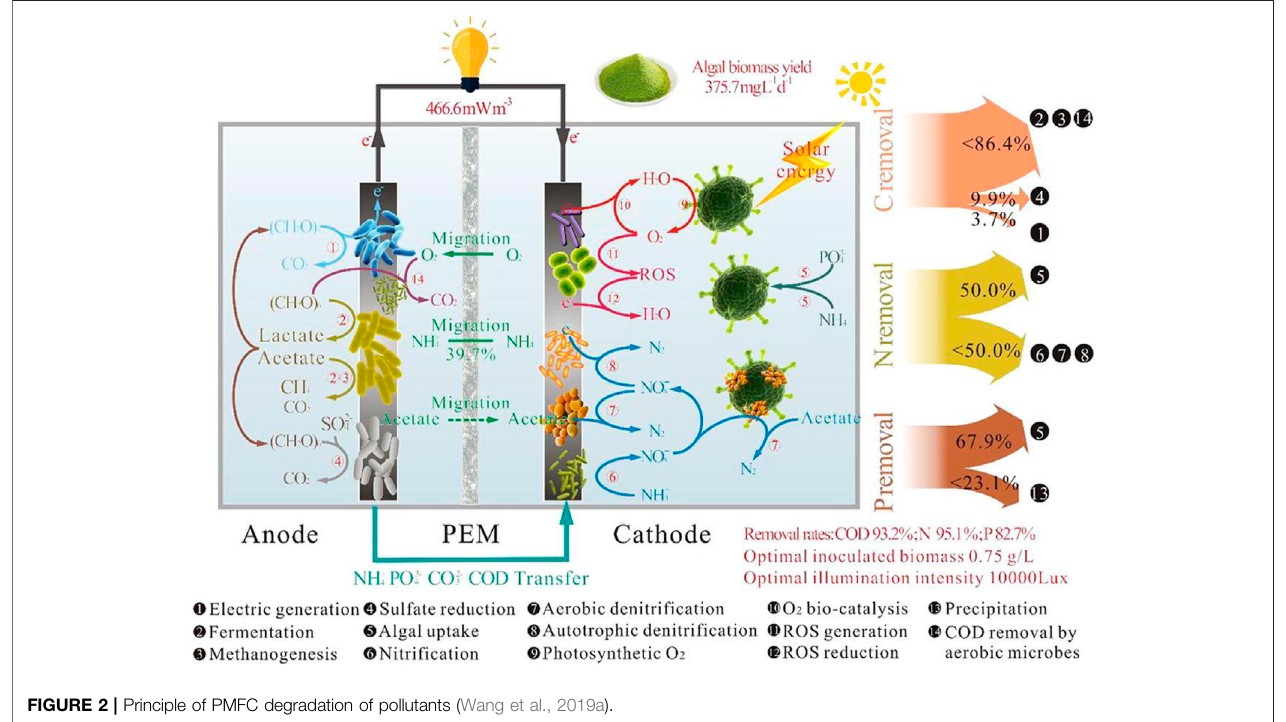
FIGURE 2 | Principle of PMFC degradation of pollutants (Wang et al., 2019a).